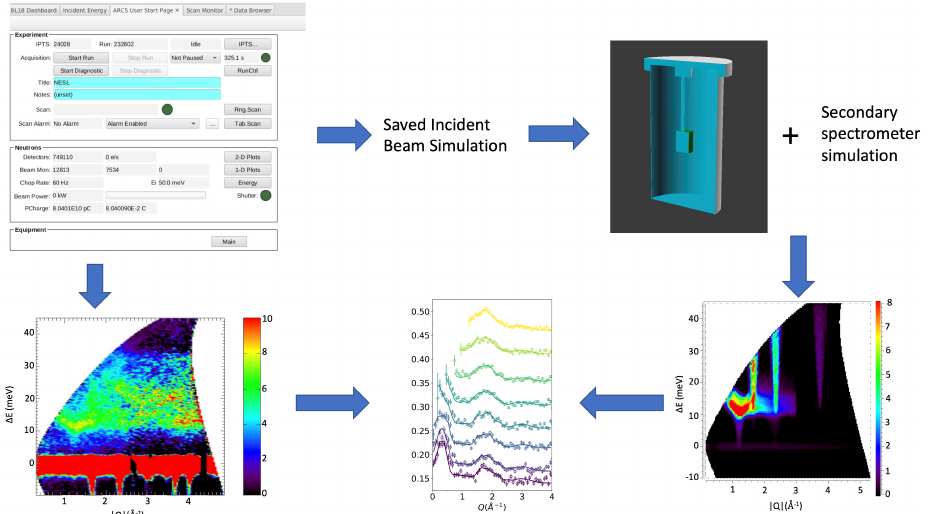
Figure 6. Example of a simulation workflow, schematic of what will be performed when the workflow is complete. The simulation of the neutron transport in the beamline is launched at the same time as data acquisition begins and can be refined during the acquisition. After the acquisition, the user combines the simulation and a description of the instrument geometry and scattering cross sections of the sample. The simulations can be plotted and compared to the measurement. The data in the plots are from ref.